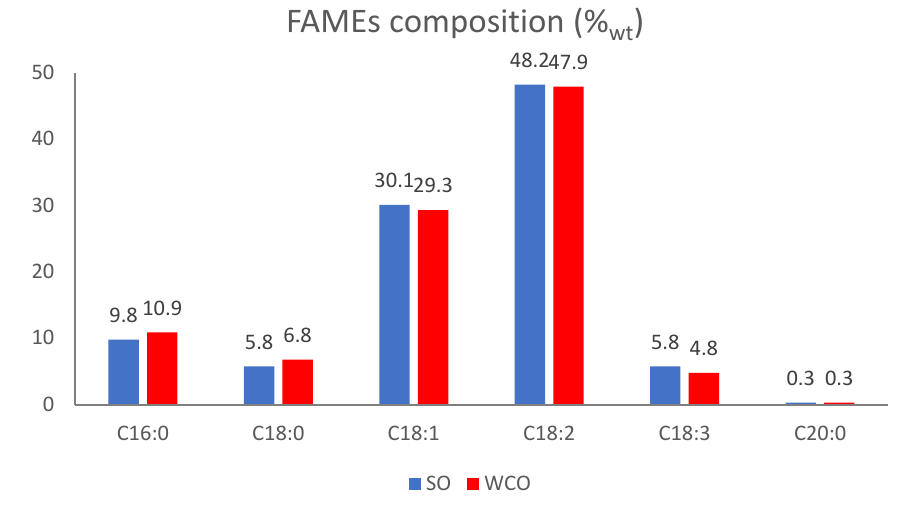
Figure 2. SO and WCO FAMEs composition (% wt ).